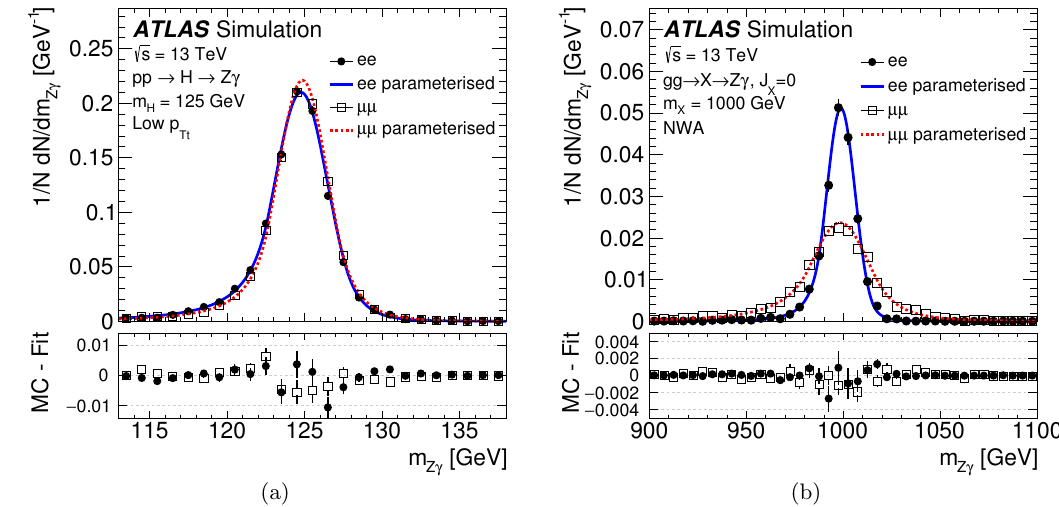
Figure 3 . The di(cid:11)erential distribution of the invariant Z(cid:13) mass ( m Z(cid:13) ) for (a) Higgs bosons with m H = 125 GeV in the low p T t categories and (b) high-mass spin-0 particles produced via gluon- gluon fusion and with m X = 1000 GeV, using the narrow width assumption (NWA). The markers show the m Z(cid:13) distributions and the solid and dotted lines the (cid:12)tted parameterisations used in the searches. The bottom part of the (cid:12)gures shows the residuals between the markers and the